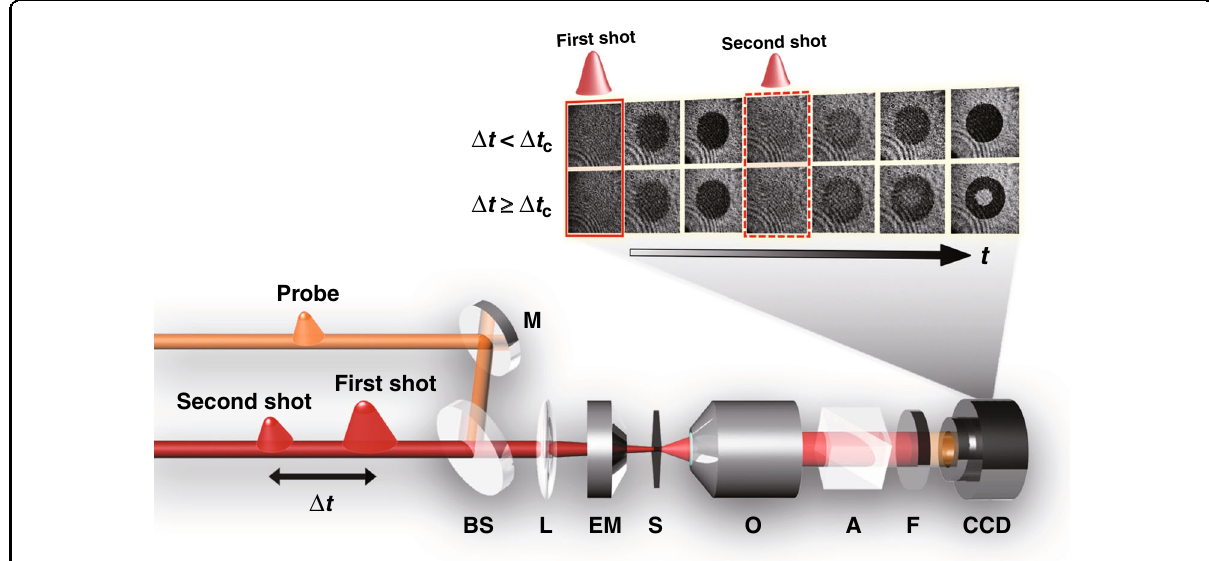
Fig. 1 Schematic of the dual-shot magnetization dynamics acquired by a time-resolved magneto-optical imaging system. M: mirror, BS: beam splitter, L: focal lens, EM: electromagnet, S: sample, O: objective, A: analyser, F: colour fi lter, CCD: charge-coupled device. The inset illustrates the magnetization dynamics of Gd 27 Fe 63.87 Co 9.13 under dual-shot excitation with certain conditions. Δ t is the shot-to-shot separation between the fi rst and second pulses. Δ t c is the critical time delay. Rewriting or restoration of the switched magnetization may occur in no less than this amount of time. The solid and dashed red frames indicate the images acquired at the arrivals of the fi rst and second shots,